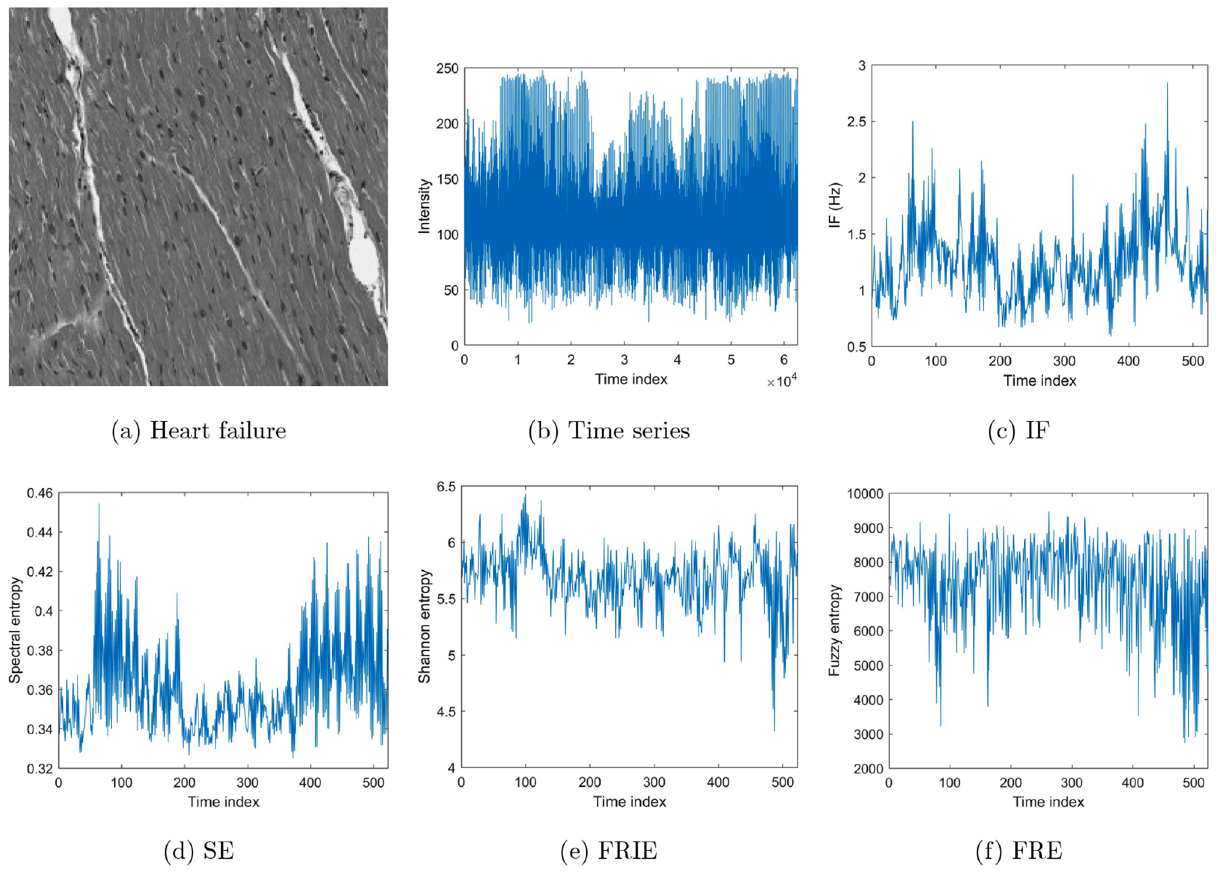
Figure 6. Time-frequency and time-space features extracted from time series of a grayscale image of H&E heart